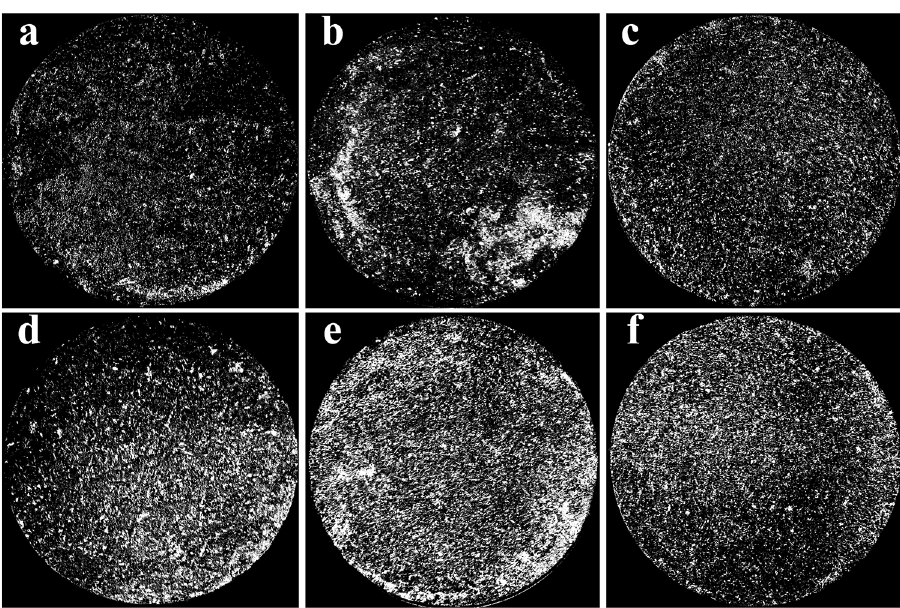
Figure 5. Binary images of soil samples with a moisture content of 13%, 1.48 g cm −3 and different freeze–thaw cycles: ( a ) N = 0, 13%, 1.48 g cm −3 (A1), ( b ) N = 1, 13%, 1.48 g cm −3 (B1), ( c ) N = 5, 13%, 1.48 g cm −3 (C1), ( d ) N = 10, 13%, 1.48 g cm −3 (D1), ( e ) N = 15, 13%, 1.48 g cm −3 (E1) and ( f ) N = 20, 13%, 1.48 g cm −3